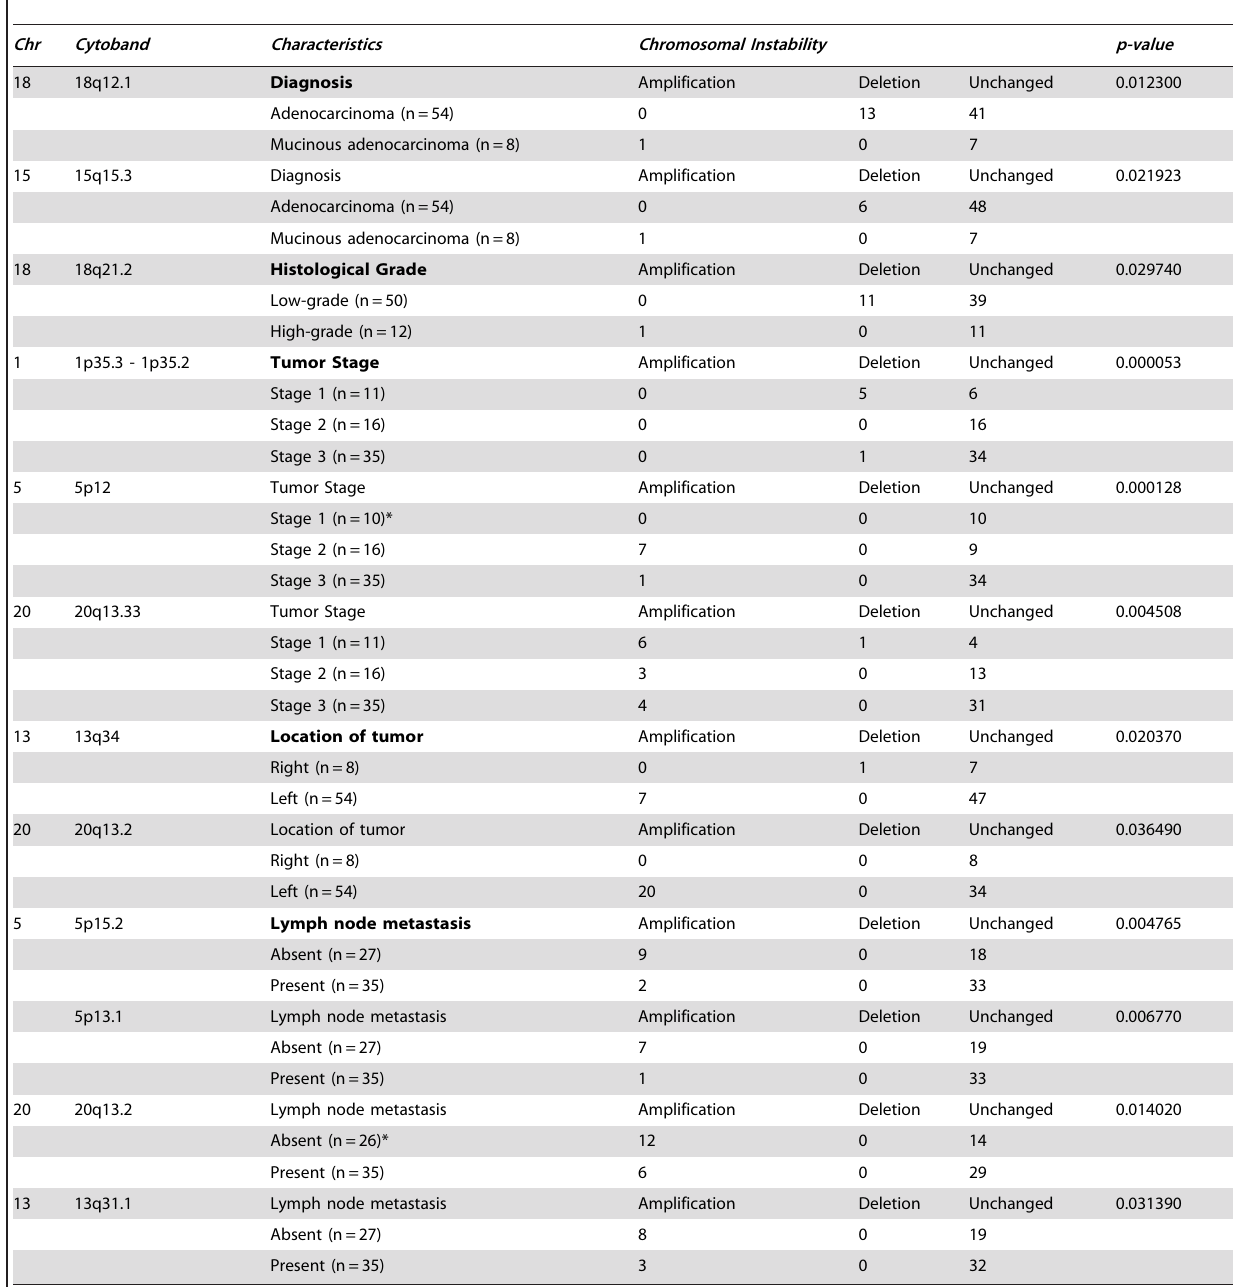
Table 3. Association of Chromosomal copy number changes with clinico-histopathological findings in MSS CRC cases (n=62).